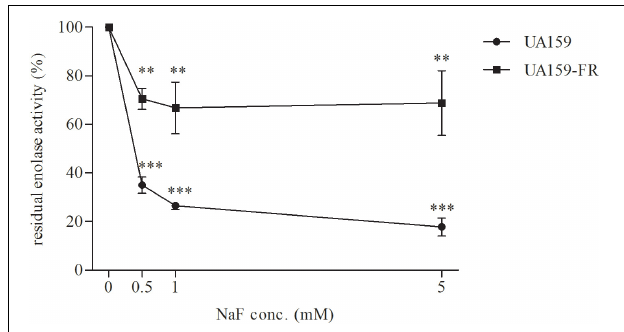
FIGURE 5 | Residual enolase activity of S. mutans UA159 and UA159-FR after pre-incubation with different concentrations of NaF. The activity of the control group in which no NaF was added during pre-incubation was set at 100%. ∗∗ p < 0.01 and ∗∗∗ p <